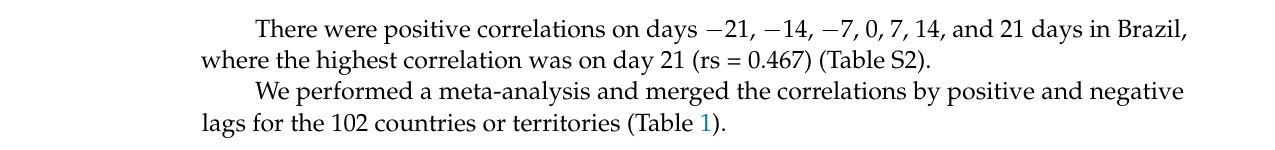
Table 1. Time-lag correlations of online search activity and daily new cases in 102 countries or territories by positive and negative lags. Negative Lags Positive Lags Countries or Territories Spearman Correlation Coefficient P -Value Spearman Correlation Coefficient P